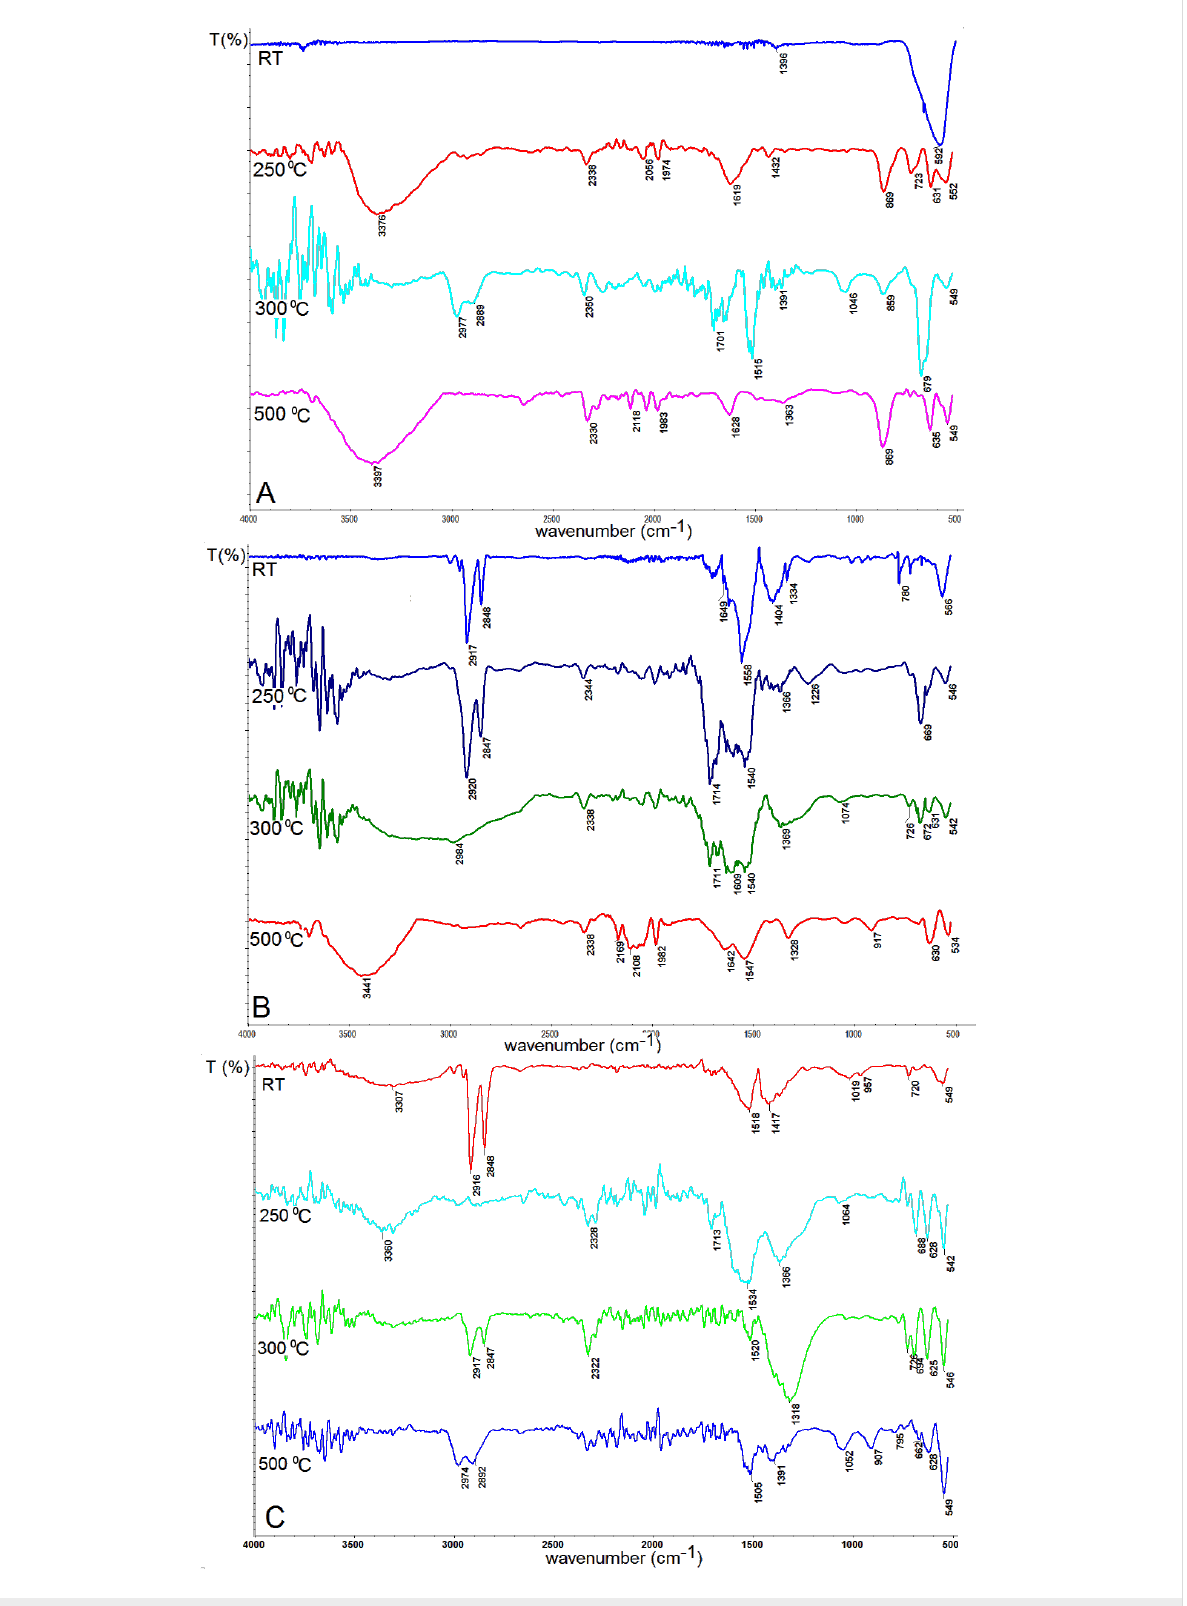
Figure 7: IR spectra of magnetite nanoparticles (A) MNP-1, (B) MNP-2, (C) MNP-3 before and during the heating